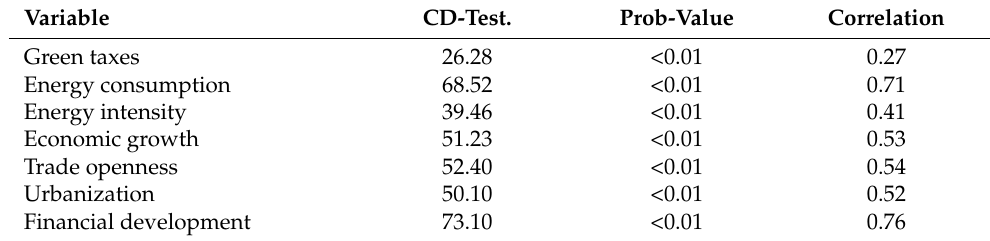
Table 3. The cross-sectional dependence testing analysis.